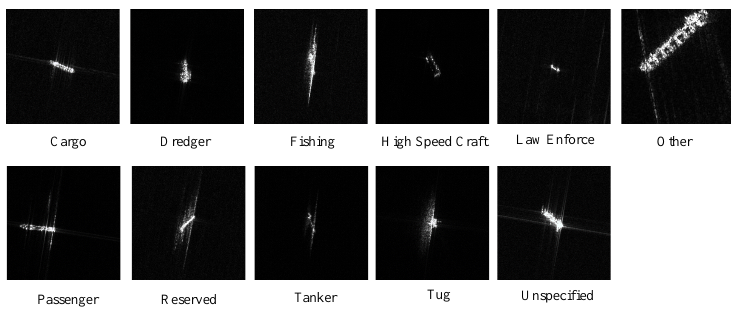
Figure 5. Different categories of ships in FUSAR-GEN dataset. Table 1. Number of objects in each category of FUSAR-GEN